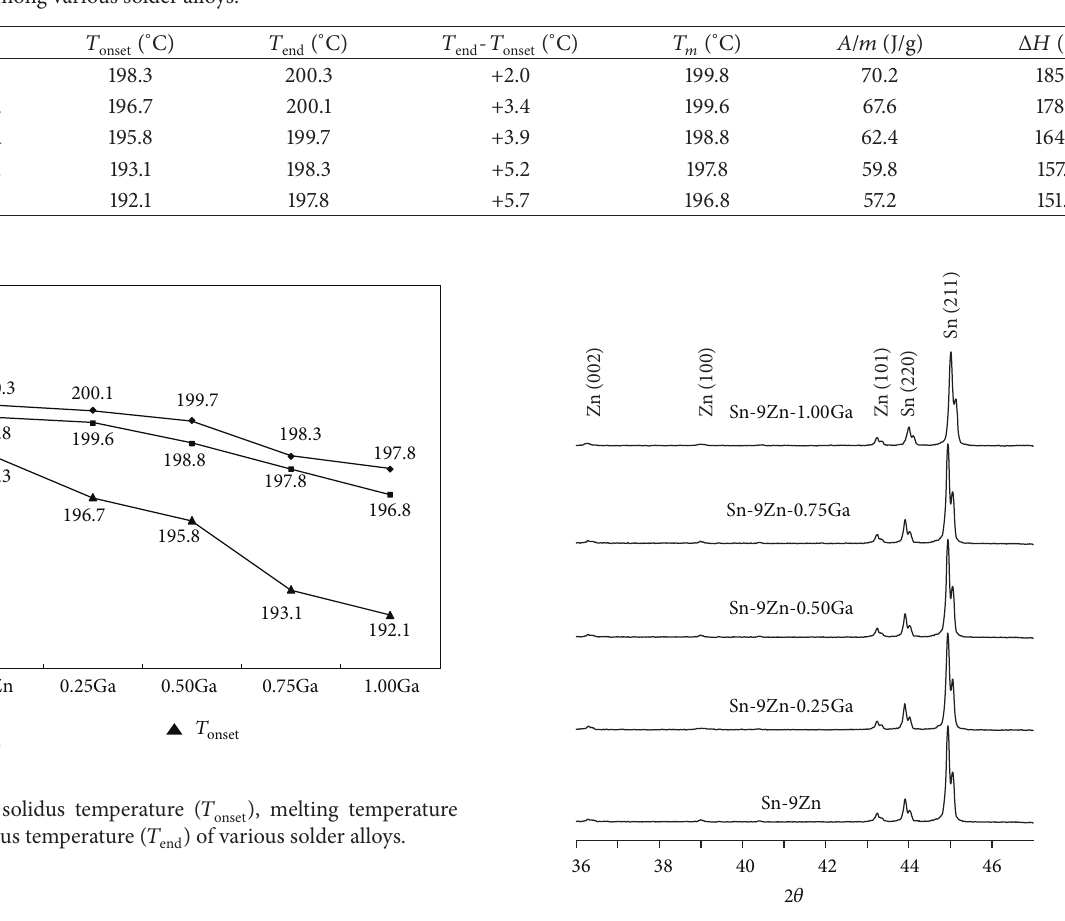
), pasty ranges ( 𝑇 - 𝑇 ), melting temperature ( 𝑇 𝑚 ), end end onset